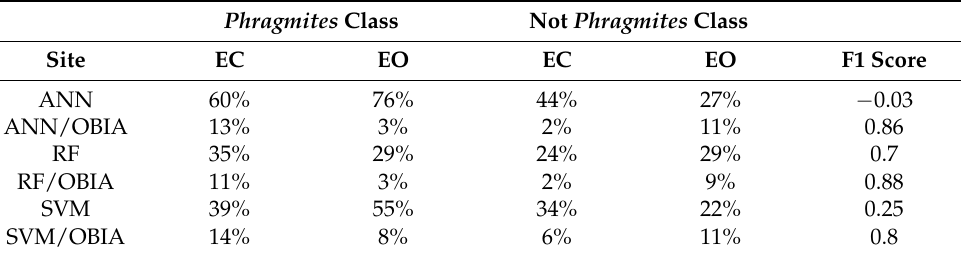
Table 23. Errors of commission (EC), errors of omission (EO), and F1 scores for Grassy Point Park for each of the classification